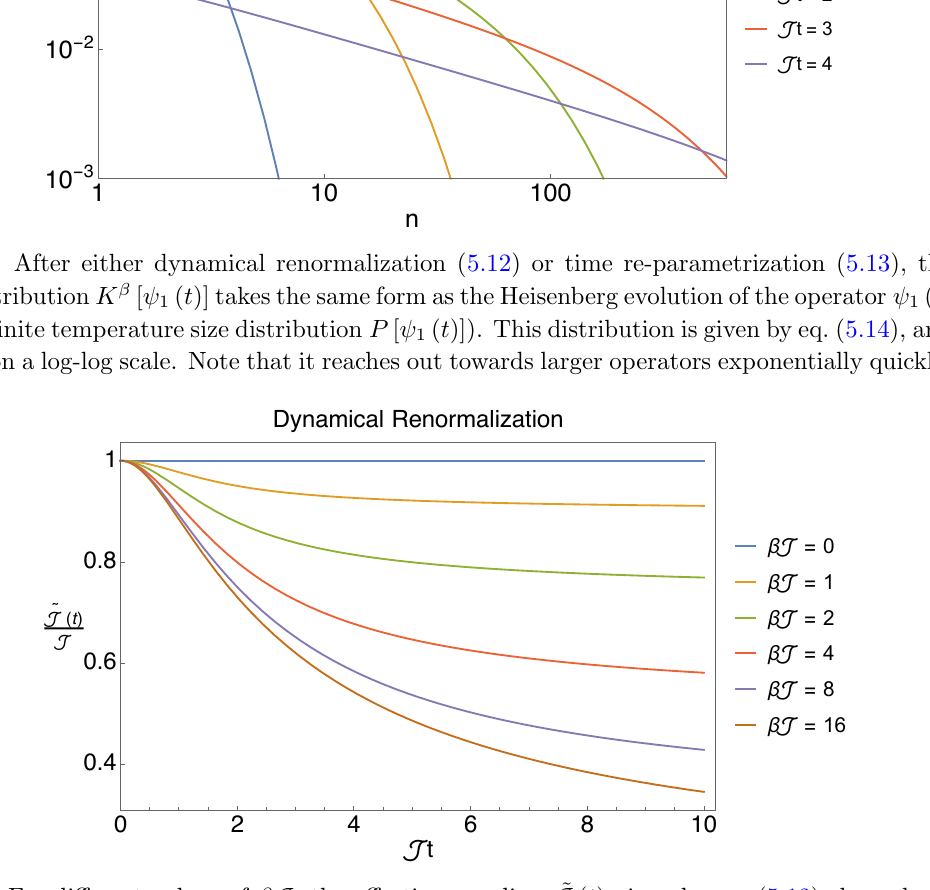
Figure 9 . For di(cid:11)erent values of (cid:12) J , the e(cid:11)ective coupling ~ J ( t ) given by eq. (5.12) slows down from J to (cid:11) on a timescale of order (cid:11) (cid:0) 1 . As always, (cid:11) is the smallest root of eq.